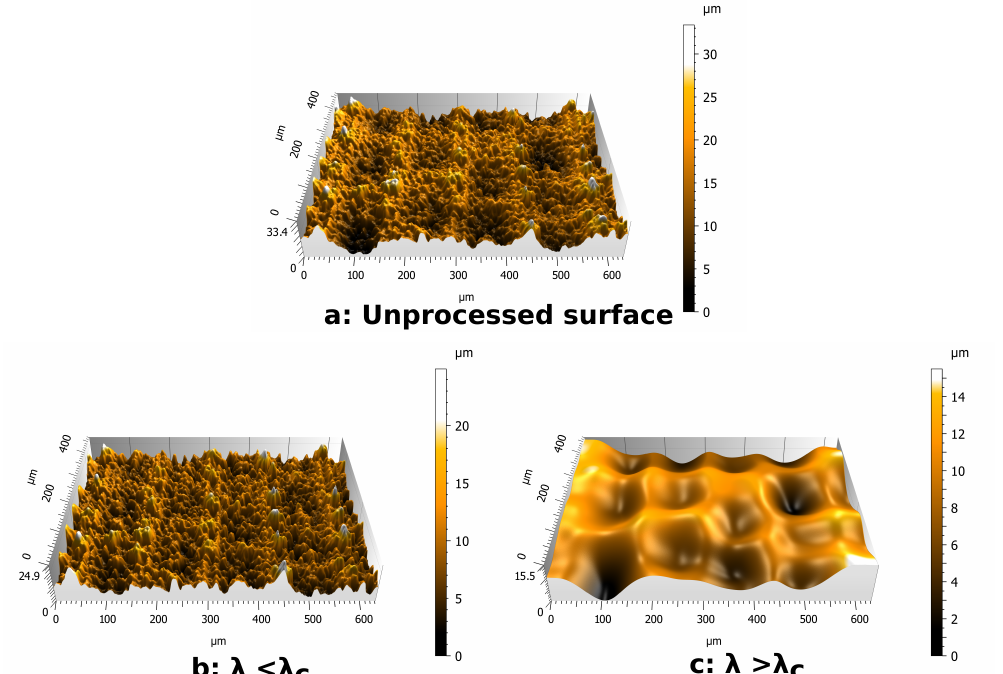
Figure 4. Example of Gaussian filtering, with a cut-off of 120 µ m, on Phyllostachys bamboo leaf: ( a ) unprocessed surface, ( b ) filtered surface for small scales, and ( c ) filtered surface for high